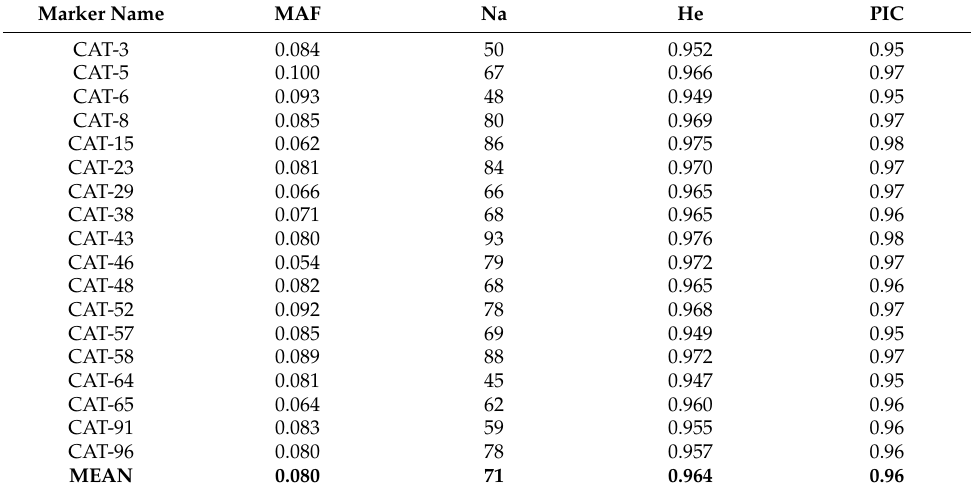
Table 3. Genetic parameters based on SSR markers.